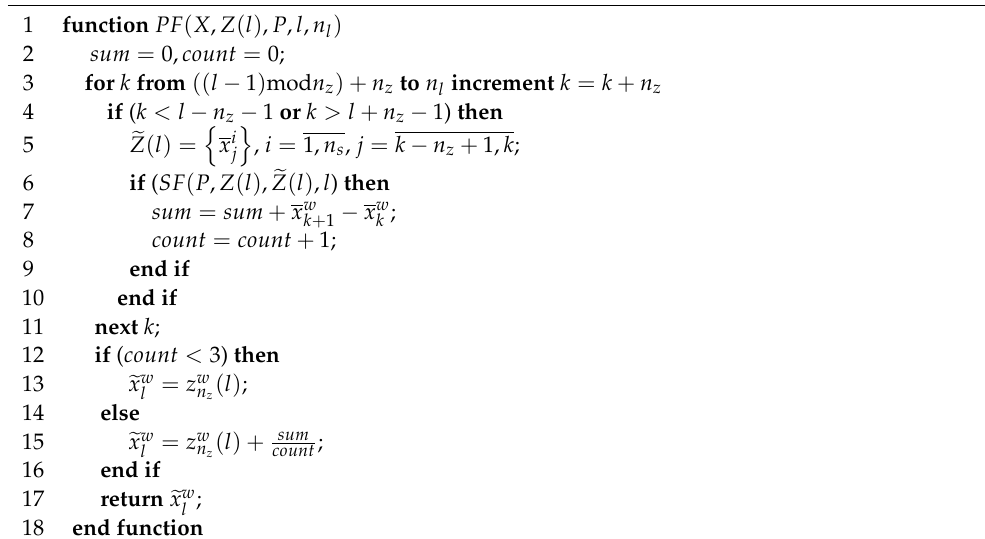
Algorithm 2. Algorithm of the PF